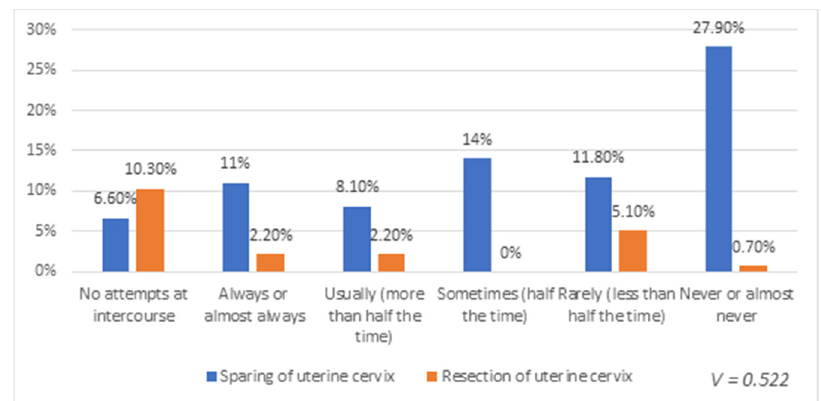
Figure 2. Relationship between the extent of surgery (resection or sparing of the cervix) and the frequency of experiencing discomfort or pain during intercourse .